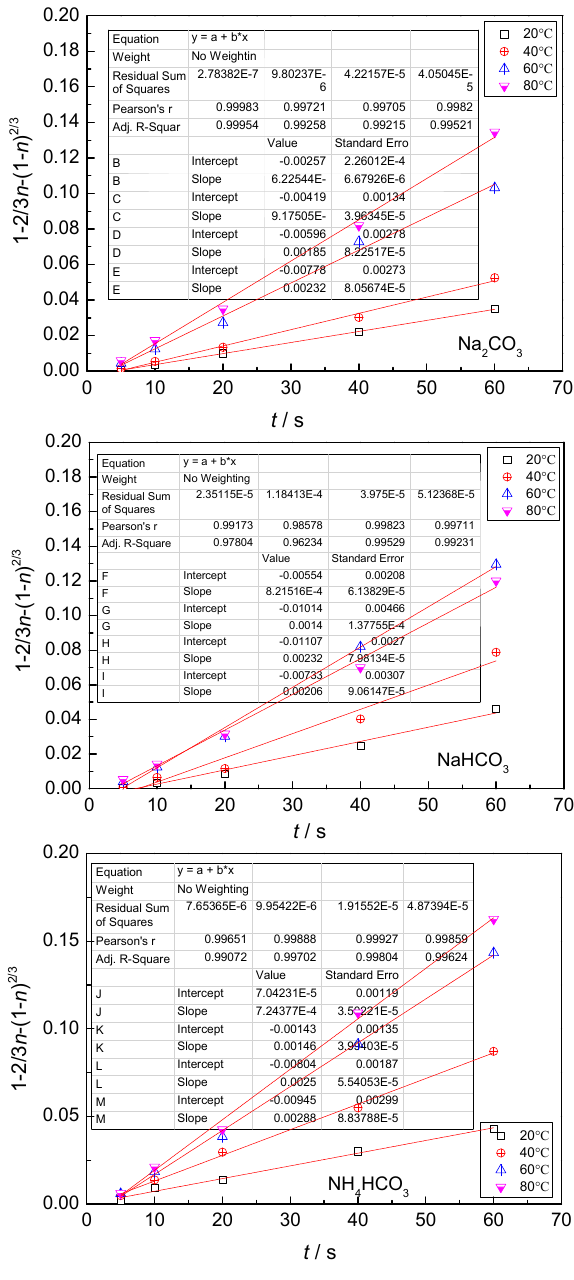
Figure 11. Linear relation between the leaching time and [1 − 2/3 η − (1 − η ) 2/3 ] (concentration of leaching agent: 1 mol/L, particle size: 96–120 μ m, the stirring rate: 90 rpm).